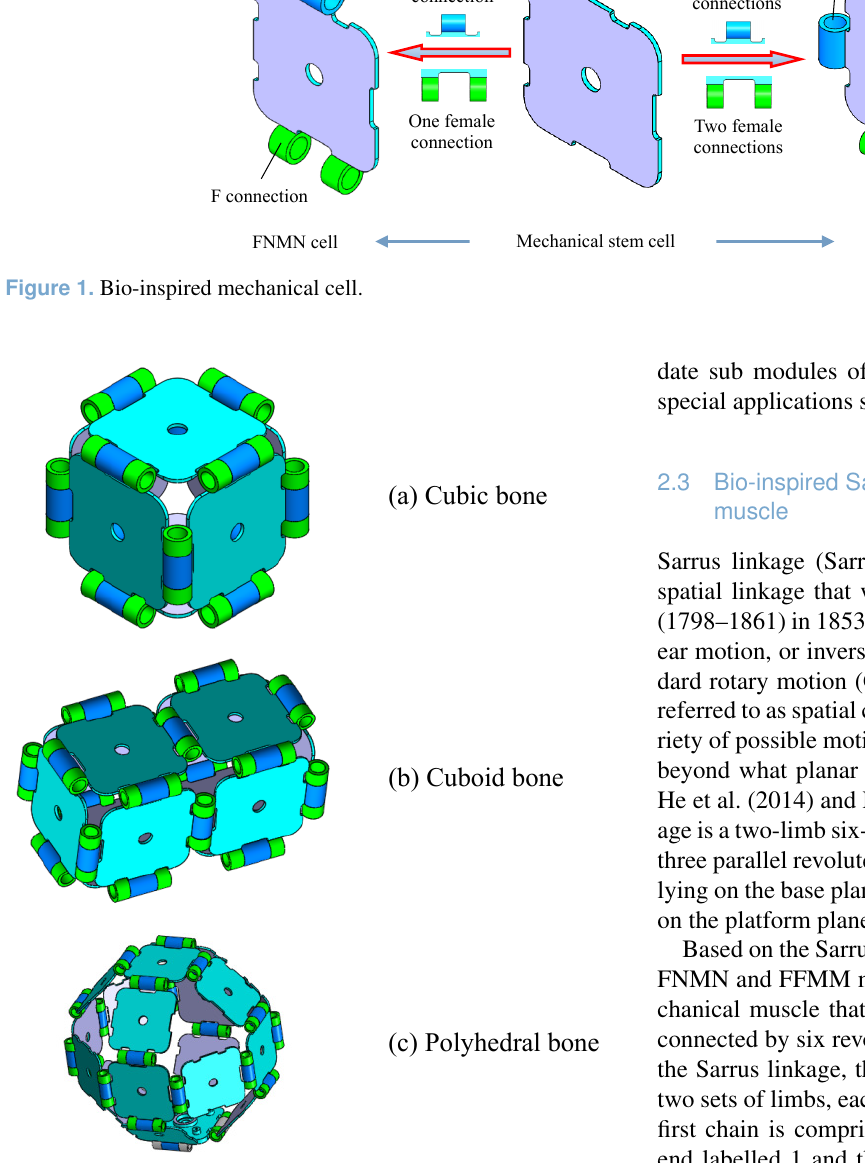
Figure 2. Bio-inspired mechanical